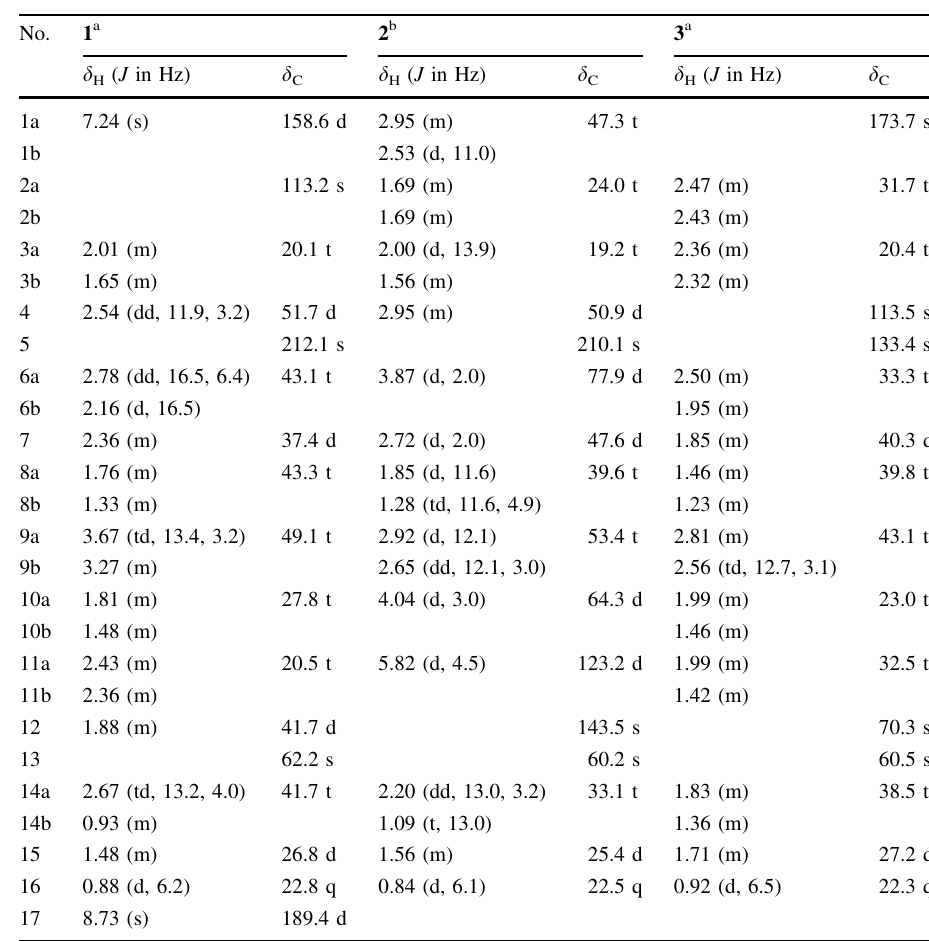
Table 1 1 H and 13 C NMR spectroscopic data of compounds 1 – 3 ( d in ppm)